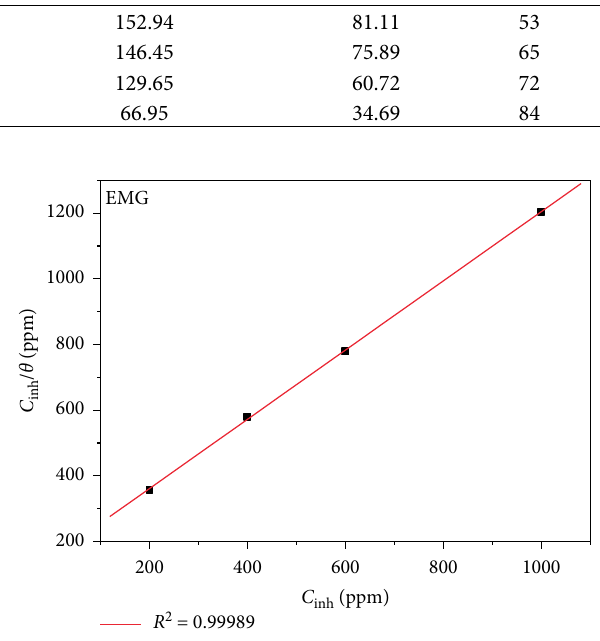
Figure 9: Langmuir adsorption of EMG on the mild steel surface in 1.0 M HCl solution at 303 K. EMG is the methanolic extract of